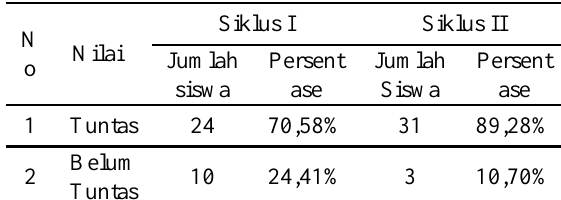
Tabel 5 . Perbandingan Distribusi Frekwensi